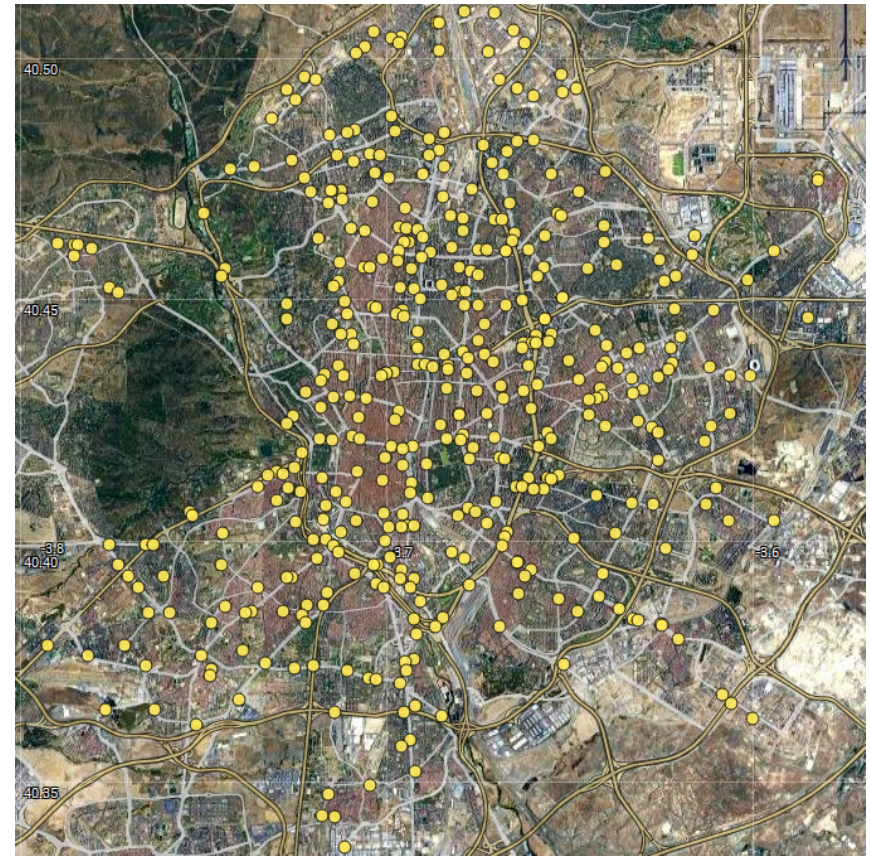
Figure 1. Map of Madrid with 340 of the 3400 sensors used for traffic